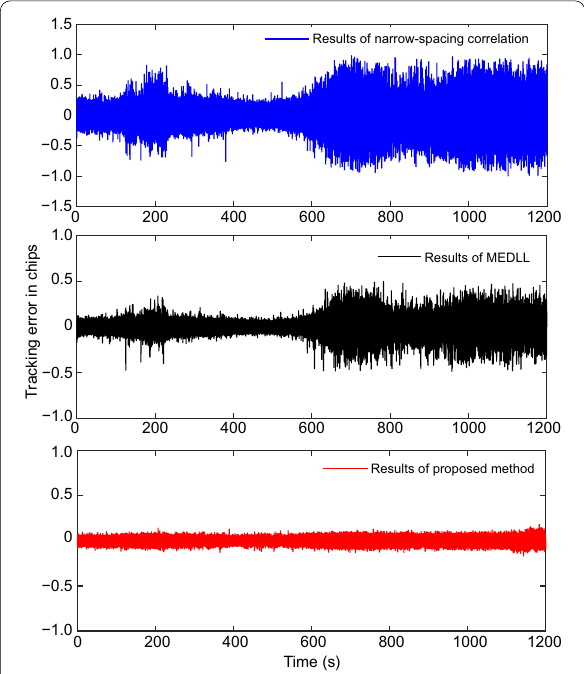
Fig. 12 Long-term tracking results of PRN 6. The top to bottom panels show the tracking results with the narrow-spacing correlation, the MEDLL, and the proposed algorithm, respectively